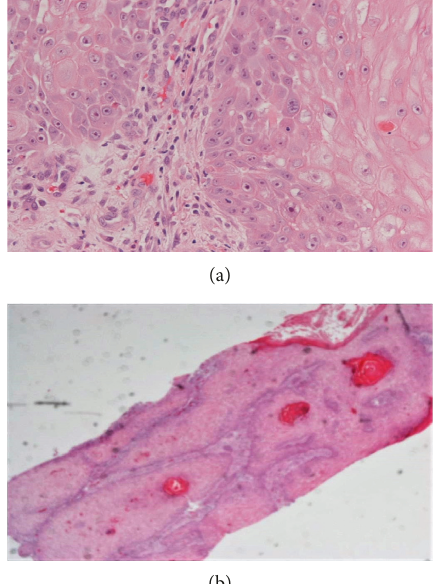
Figure 6: Photomicrograph of punch biopsy from the second ulcerative lesion (H&E stain). This demonstrates full-thickness infiltration by a well-differentiated keratinising SCC. (a) × 20 magnification. (b) × 2.5 magnification.